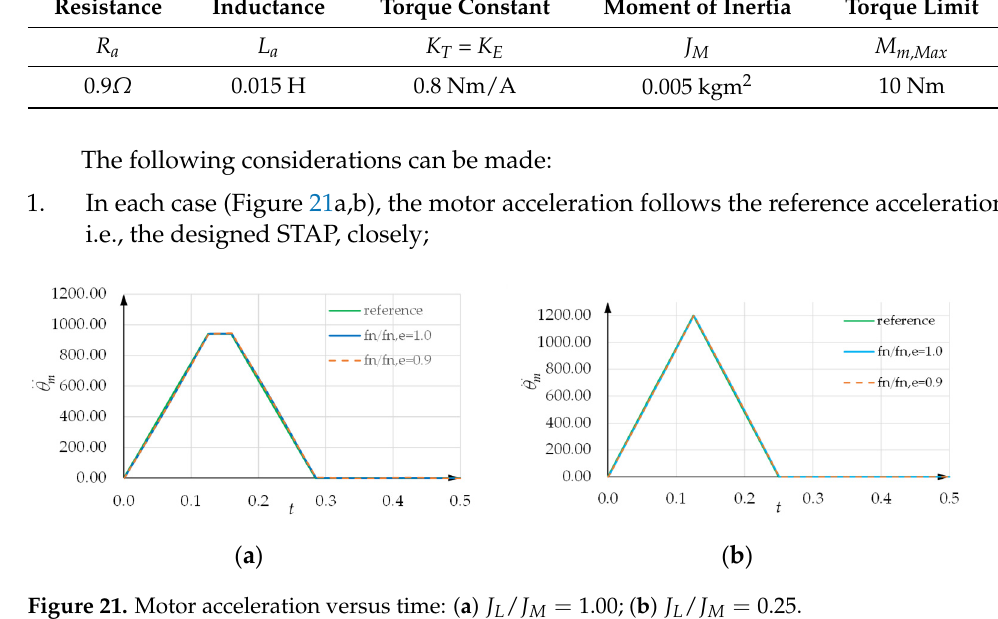
Figure 20. Control block diagram. Table 2. Characteristics of the motor in consideration. Resistance